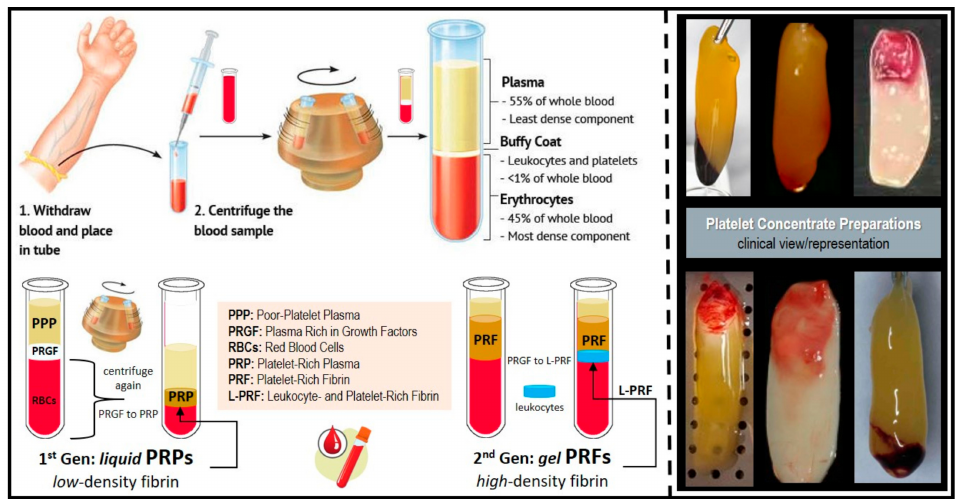
Figure 1. Platelet concentrates’ clinical preparation, types/classes, and clinical illustration/presentation of several platelet-rich fibrin (PRF) and leukocyte and platelet-rich fibrin (L-PRF) preparations (membranes).